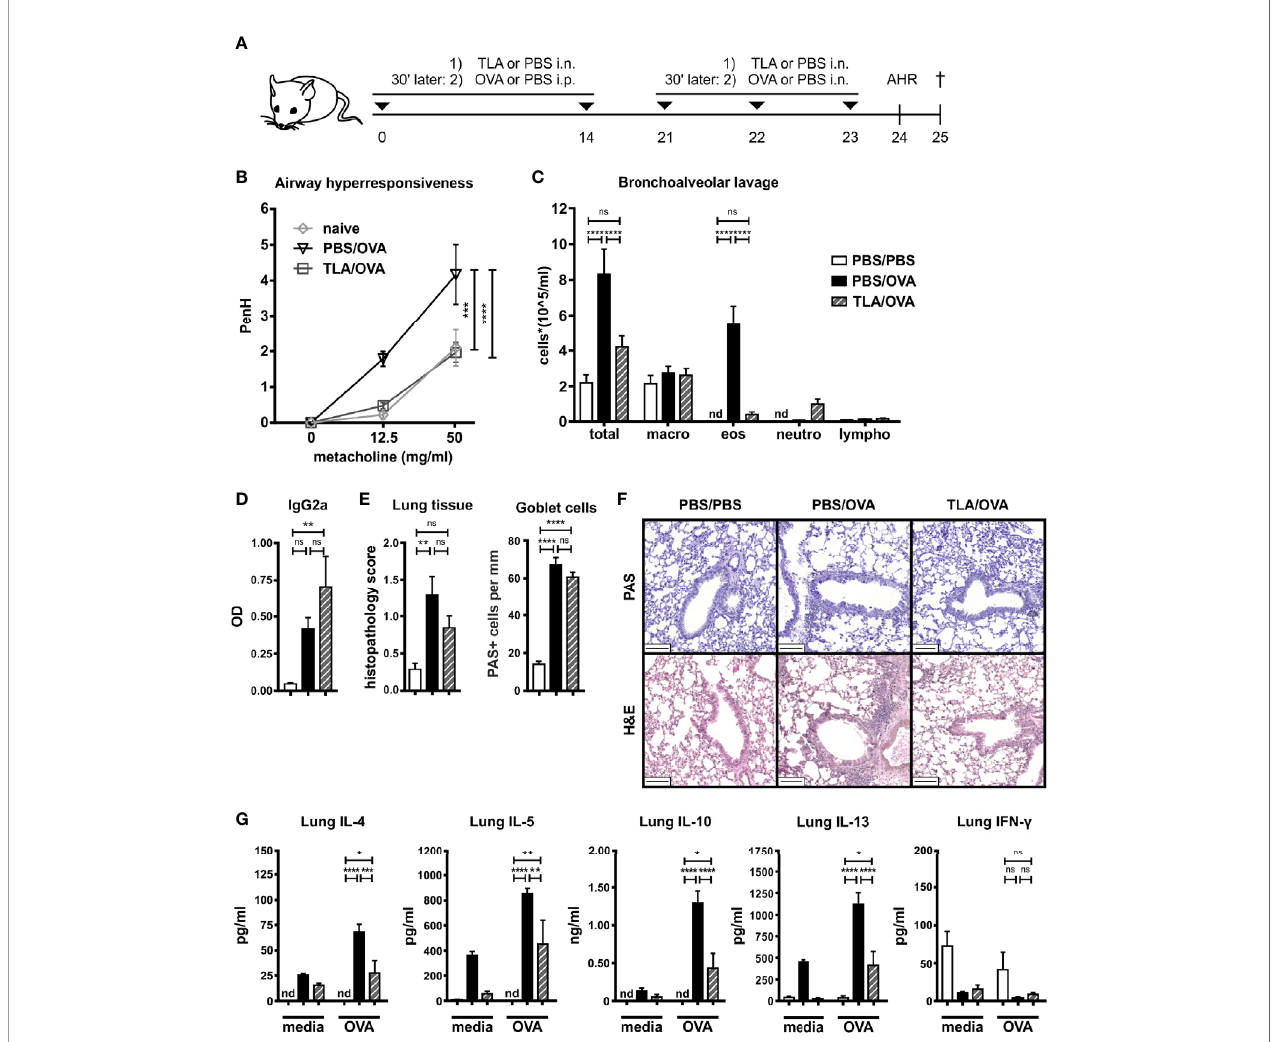
FIGURE 2 | TLA reduces allergic airway in fl ammation in a co-application model. (A) , Experimental design. (B) Airway hyperresponsiveness in response to methacholine. (C) Differential cell count in bronchoalveolar lavage (BALF). (D) Levels of OVA-speci fi c antibody IgG2a in BALF collected at the end of the experiment. (E) Average histopathology score and number of Periodic acid-Schiff (PAS)-positive goblet cells of lung sections. (F) PAS or hematoxylin and eosin (H&E)-stained lung sections from 1 representative example from each group (n = 5); scale bars, 100µm. (G) Levels of IL-4, IL-5, IL-10, IL-13, and IFN- g after medium and OVA restimulation of lung cells. Graphs show results from 1 experiment with 5 mice per group ( Figure 2B , PBS/PBS group in Figures 2C – G ) or from 1 representative experiment from 2 independent experiments with 5 mice per group (groups PBS/OVA and TLA/OVA, Figures 2C – G ). Error bars show mean ± SEM. TLA , tachyzoites lysate antigen; OVA , ovalbumin; i.n. , intranasal; i.p. , intraperitoneal; macro , macrophages; eos , eosinophils; neutro , neutrophils; lympho , lymphocytes; nd , not detectable; ns , not signi fi cant; OD , optical density; *P < 0.05; ** P < 0.01; *** P < 0.001; ****P <